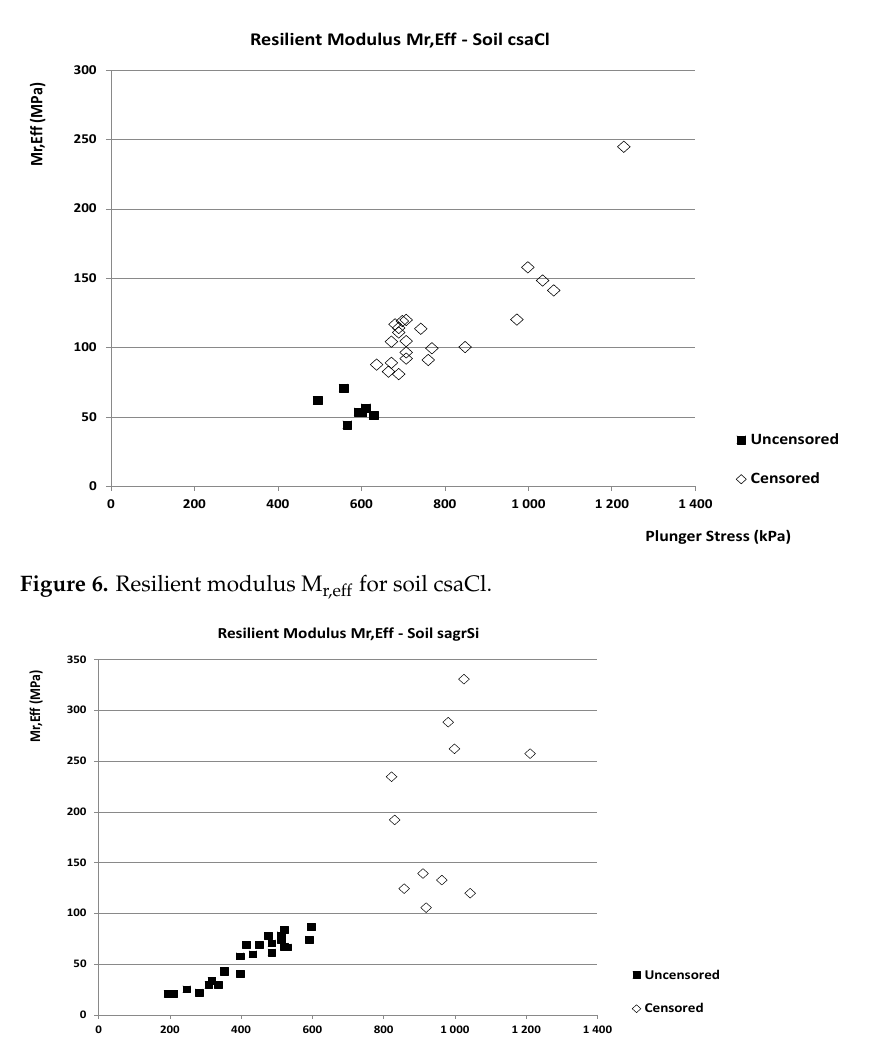
Figure 7. Resilient modulus M r,eff for soil sagrSi.